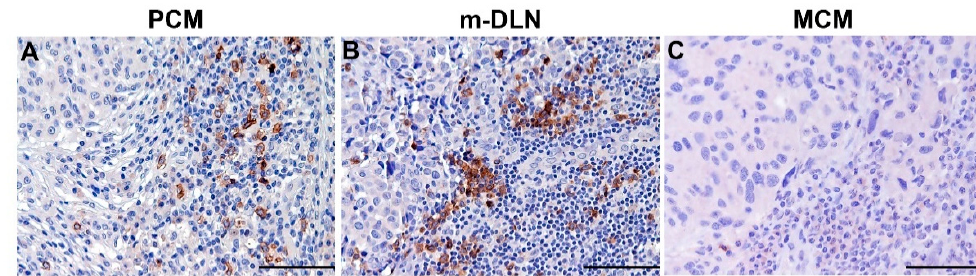
Figure 4. pDCs distribution in melanoma. FFPE sections stained with anti-BDCA-2 (clone 124B3.13, 1:75, Dendritics) and revealed using Novolink Polymer (Leica Microsystems) followed by 3,3 ′ -diaminobenzidine (DAB) as chromogen. pDC infiltration is evident in primary cutaneous melanoma (PCM) ( A ) and melanoma-draining lymph nodes (m-DLN) ( B ), whereas the metastatic site (MCM) is devoid of pDCs ( C ). Magnification 200× (scale bar 100 µm).